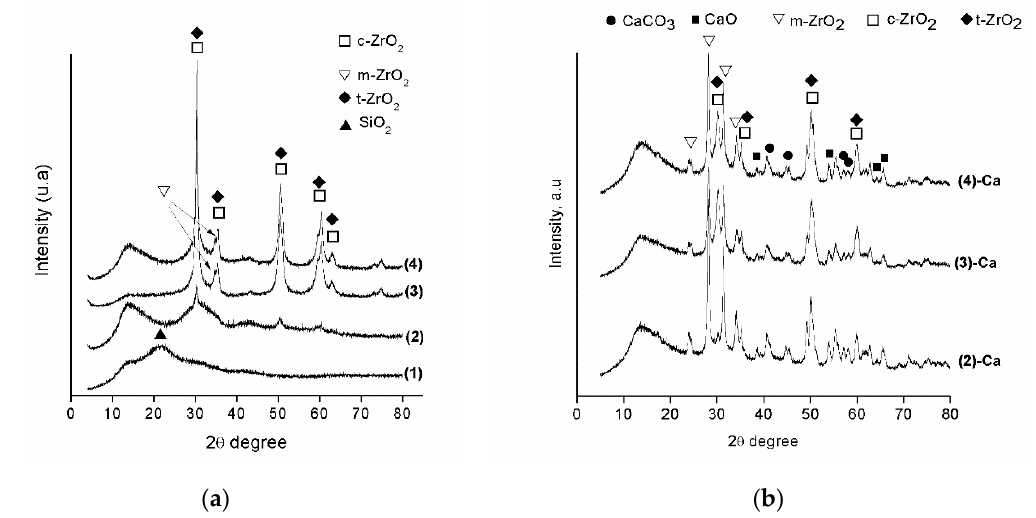
Figure 9. X-ray di ff raction (XRD) profiles: ( a ) SiO 2 sphere (1), SiO 2 @ZrO 2 0.04 M (2), SiO 2 @ZrO 2 Figure 9. X-ray diffraction (XRD) profiles: ( a ) SiO 2 sphere (1), SiO 2 @ZrO 2 0.04M (2), SiO 2 @ZrO 2 0.06M 0.06 M (3) and SiO 2 @ZrO 2 0.08 M(4) calcined at 700 ◦ C, ( b ) SiO 2 @ZrO 2 0.04 M–CaO (2)-Ca, SiO 2 @ZrO 2 (3) and SiO 2 @ZrO 2 0.08M(4) calcined at 700 °C, ( b ) SiO 2 @ZrO 2 0.04M–CaO (2)-Ca, SiO 2 @ZrO 2 0.06M– 0.06 M–CaO (3)-Ca and SiO 2 @ZrO 2 0.08 M–CaO CaO (3)-Ca and SiO 2 @ZrO 2 0.08M–CaO (4)-Ca.